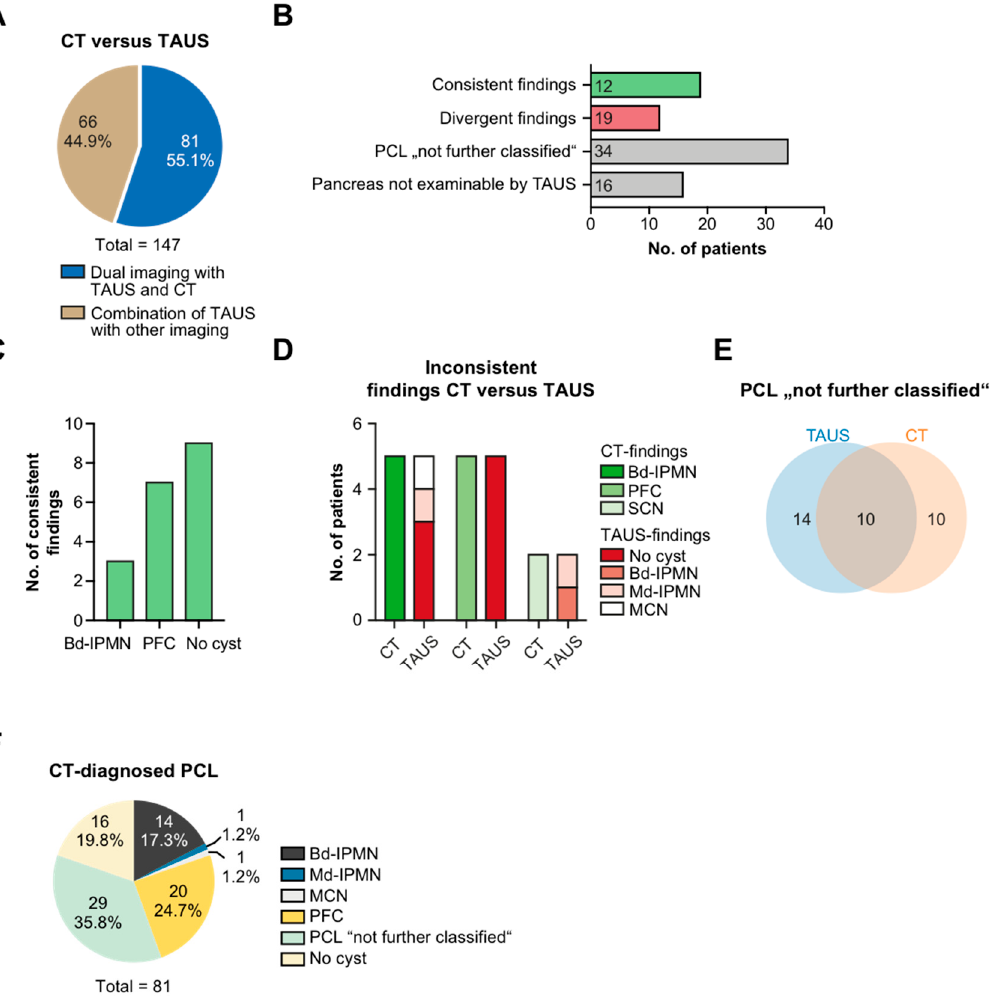
Figure 4. Diagnostic accordance between TAUS and CT scans. ( A ) Patients with dual imaging com- bining TAUS with CT or other type of imaging. ( B ) Patients (in absolute numbers) with CT and TAUS assigned to the categories “consistent findings”, “divergent findings”, “PCL not further classified”, and “Pancreas not examinable by TAUS”. ( C ) Distribution of consistent findings. ( D ) Inconsistent findings between TAUS and CT. ( E ) Venn diagram: non-classifiable PCLs on TAUS and CT. ( F ) Diagnostic categorization of PCL evaluated by CT (in absolute numbers). Transabdominal ultrasound, TAUS; computed tomography, CT; intraductal papillary mucinous neoplasm, IPMN; main duct type-IPMN, md-IPMN; branch duct type-IPMN, bd-IPMN; mucinous cystic neoplasm, MCN; serous cystic neoplasm, SCN; post-pancreatitis fluid collection, PFC; pancreatic cystic lesion, PCL.